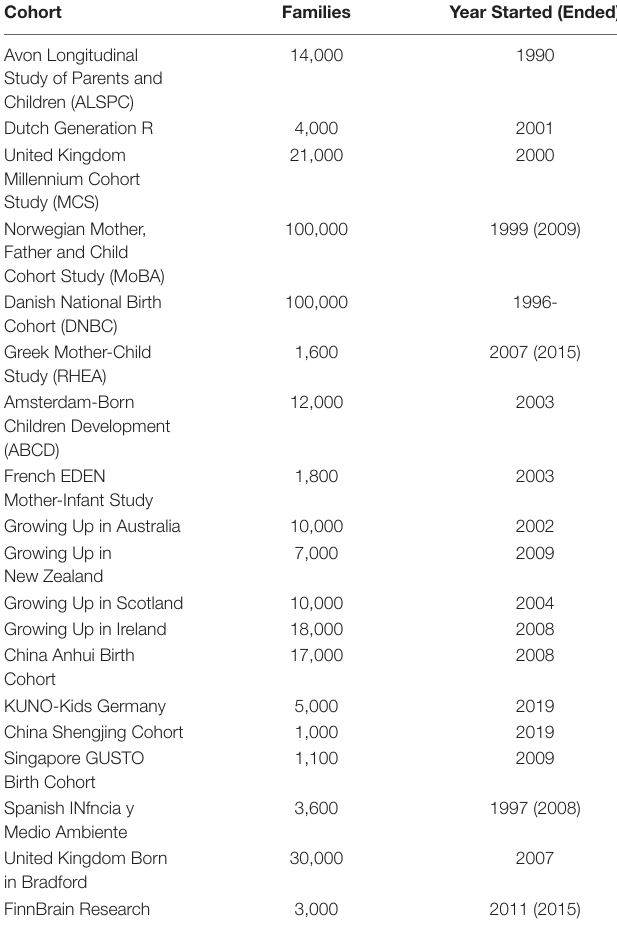
TABLE 2 | Birth cohort